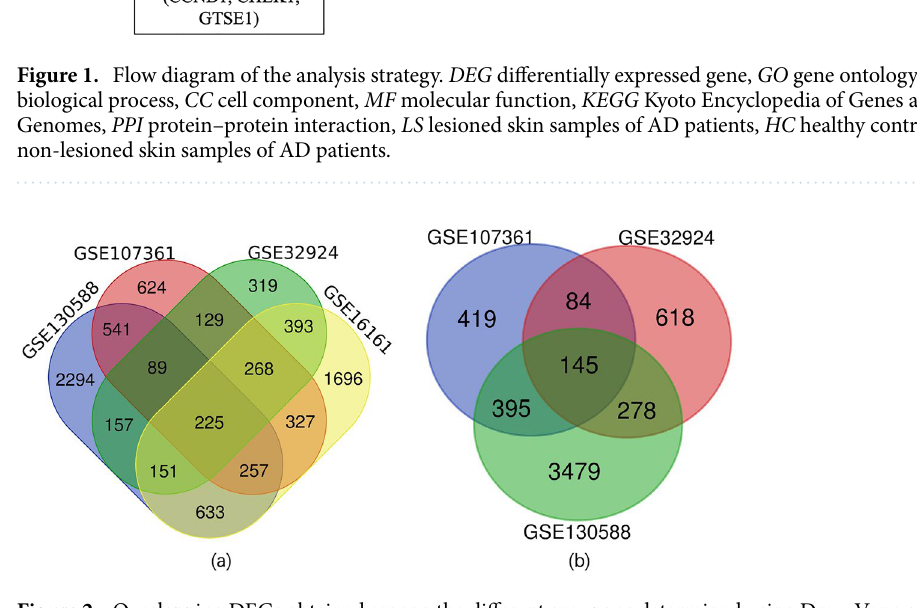
Figure 2. Overlapping DEGs obtained among the different groups as determined using Draw Venn software. ( a ) lesioned skin samples of AD patients versus healthy controls; ( b ) non-lesioned skin samples of AD patients versus healthy